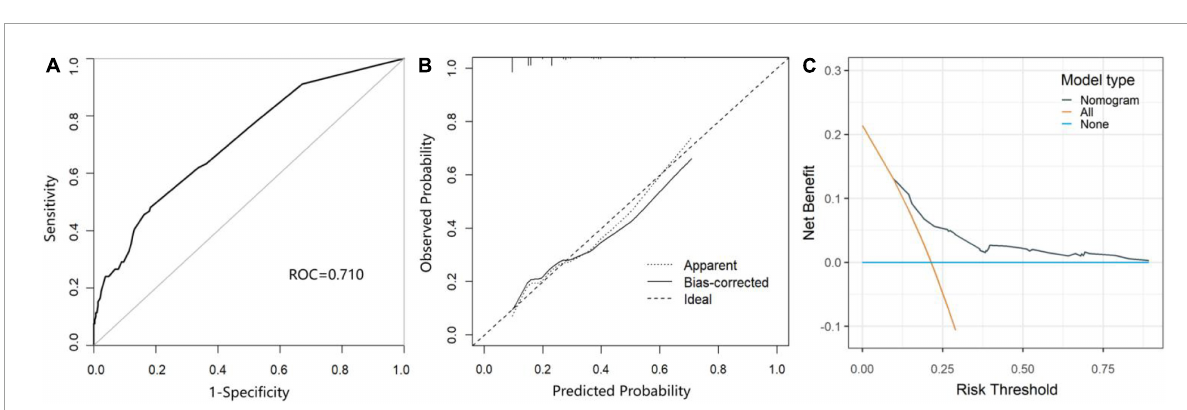
FIGURE3 The performance and validation of the nomogram. (A) The receiver operating characteristic (ROC) curve of the prediction model for POCD. (B) The calibration curve of the nomogram-predicted probability of POCD. (C) Decision curve analysis (DCA) for the